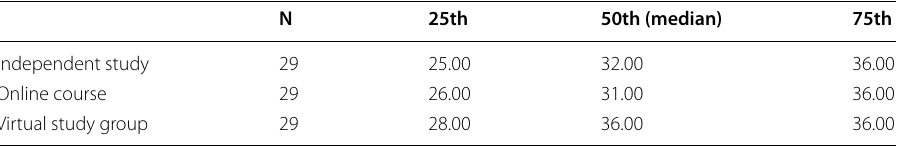
Table 4 Learning modality